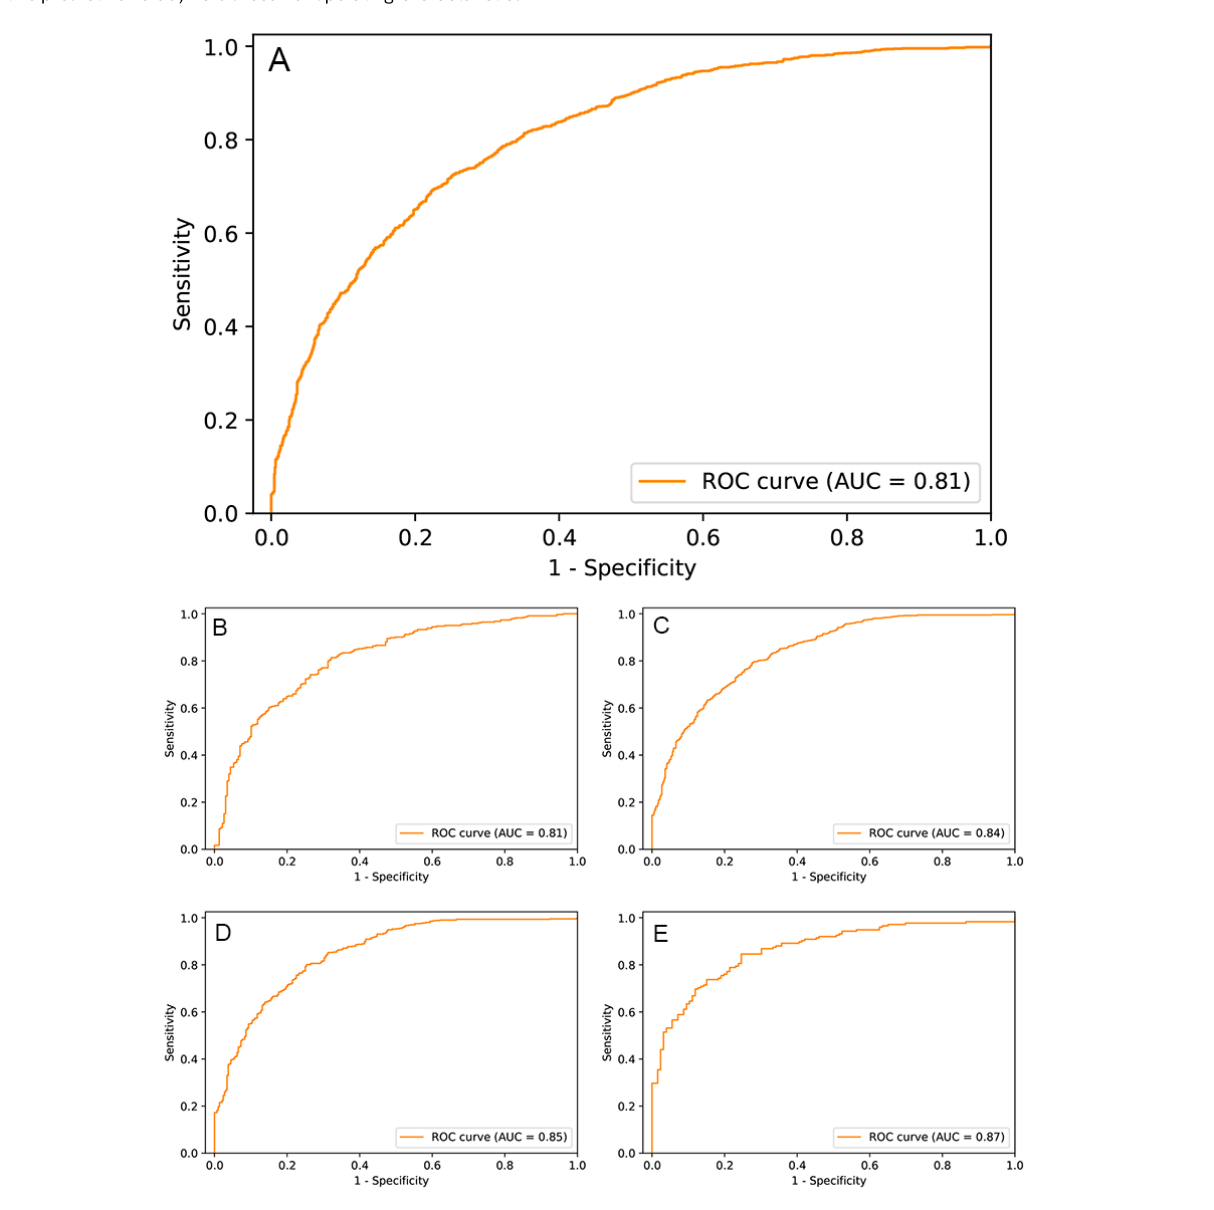
Figure 2. ROC curves for the model in detecting early renal function impairment in different groups of patients. ROC curves for (A) all patients (AUC = 0.81, sensitivity = 0.83, specificity = 0.62, PPV = 0.73, accuracy = 0.73); (B) patients with HbA 1c ≤ 6.5% (AUC = 0.81, sensitivity = 0.84, specificity = 0.62, PPV = 0.77, accuracy = 0.75), (C) patients with HbA 1c > 6.5% (AUC = 0.84, sensitivity = 0.89, specificity = 0.61, PPV = 0.77, accuracy = 0.77), (D) patients with HbA 1c > 7.5% (AUC = 0.85, sensitivity = 0.89, specificity = 0.60, PPV = 0.82, accuracy = 0.79), and (E) patients with HbA 1c > 10.0% (AUC = 0.87, sensitivity = 0.89, specificity = 0.61, PPV = 0.77, accuracy = 0.77). AUC: area under the curve; HbA 1c : hemoglobin A 1c ; PPV: positive predictive value; ROC: receiver operating